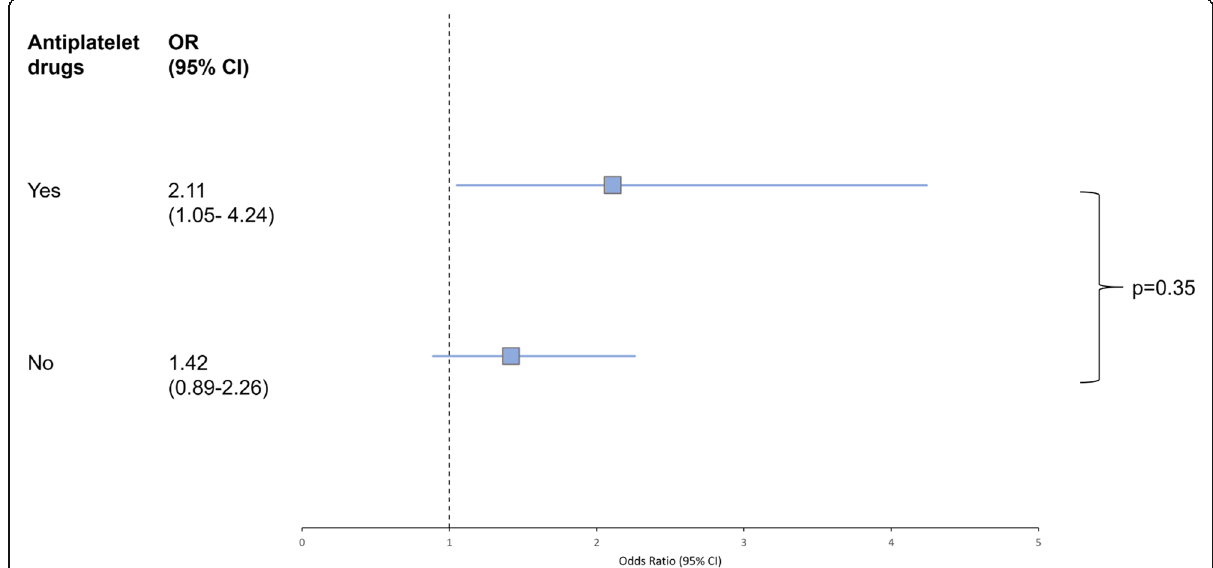
Fig. 2 Effect of alteplase on favorable outcome. Forest plots demonstrate a higher chance of a favorable functional outcome for patients treated with alteplase in both patients with prior APT and without. There was no significant interaction in the corresponding unconditional logistic regression model